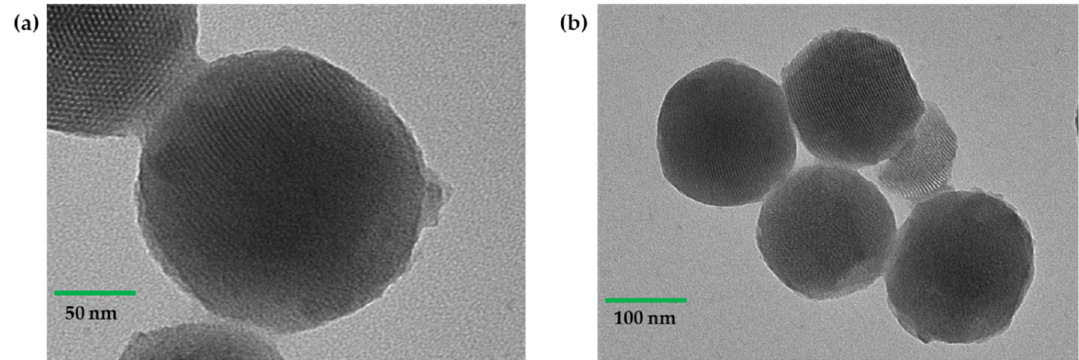
Figure 2. TEM images demonstrating the diameter and internal structure of MSNs: ( a ) MSNs images on the 50 nm scale-bar, demonstrating well-defined ordered long-range structure of inner mesopores. ( b ) MSNs on the 100 nm scale-bar, demonstrating highly ordered porous channels.